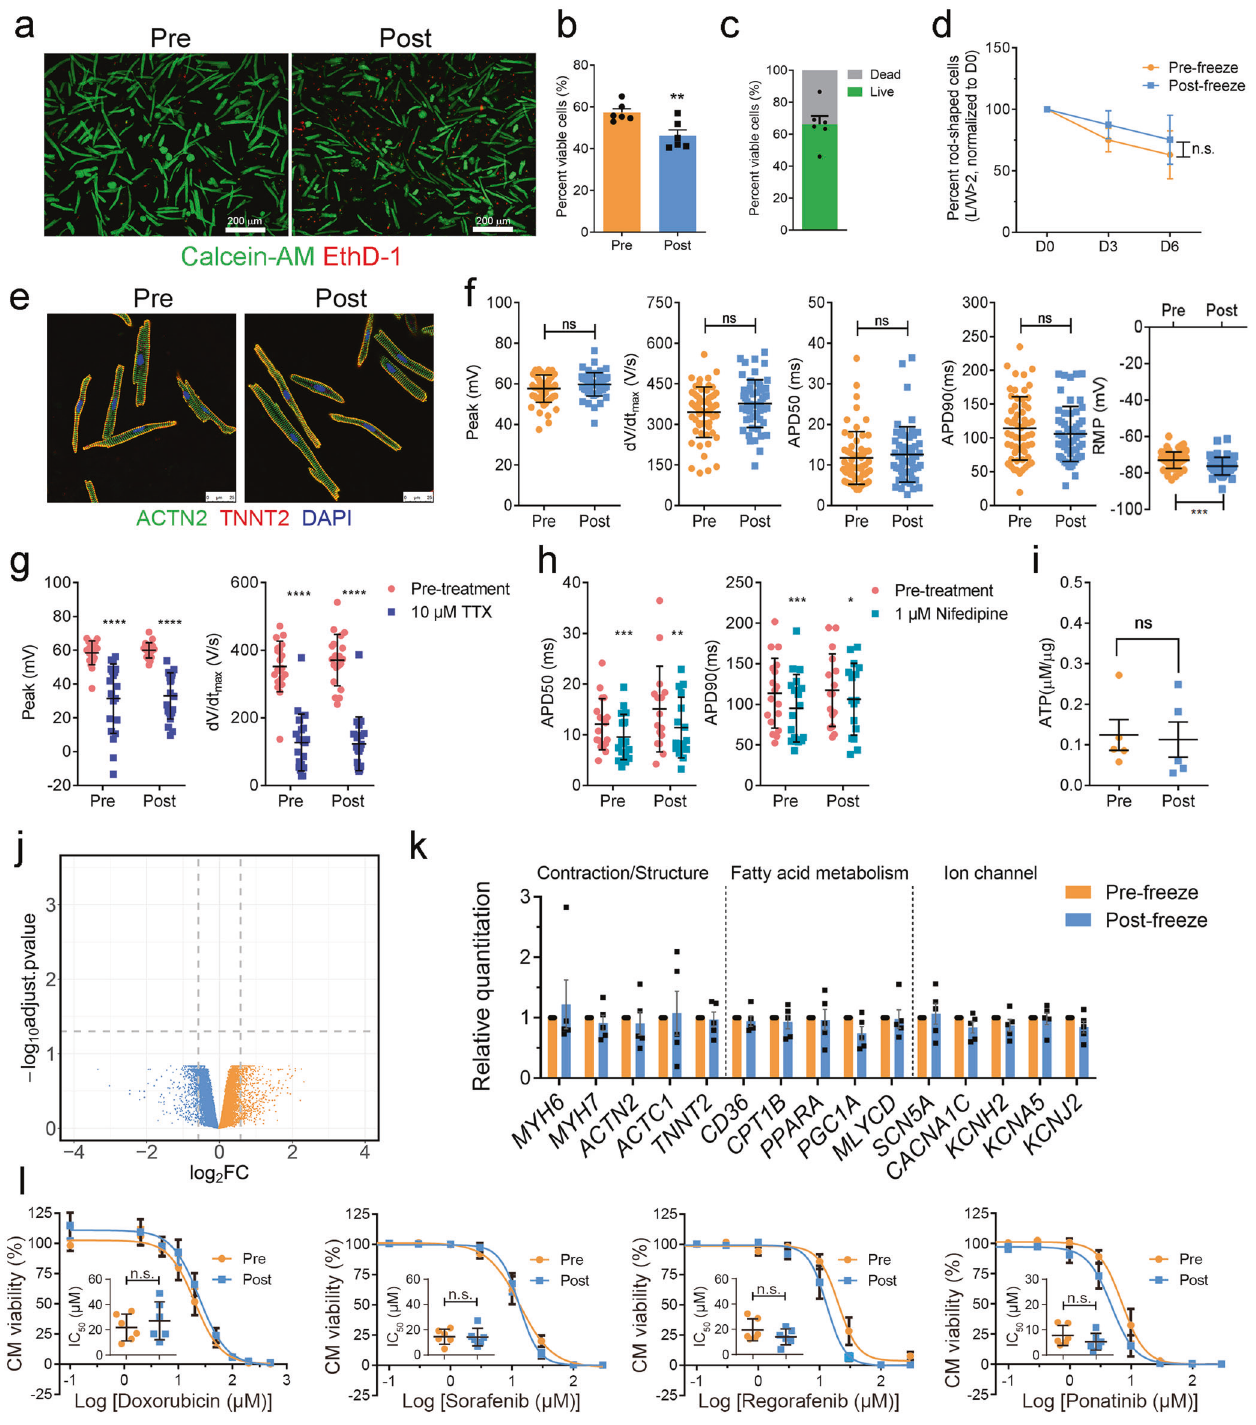
drugs of multiple categories that had been withdrawn from the market due to cardiac side effects. We measured the dose responses of these drugs both in hPCMs and hiPSC-CMs. Cisapride, droperidol, rofecoxib, and rosiglitazone all exhibited markedly lower IC 50 values in hPCMs than in hiPSC-CMs (Fig. 6a, b), indicating that hPCMs may be more sensitive to direct cardiomyocyte